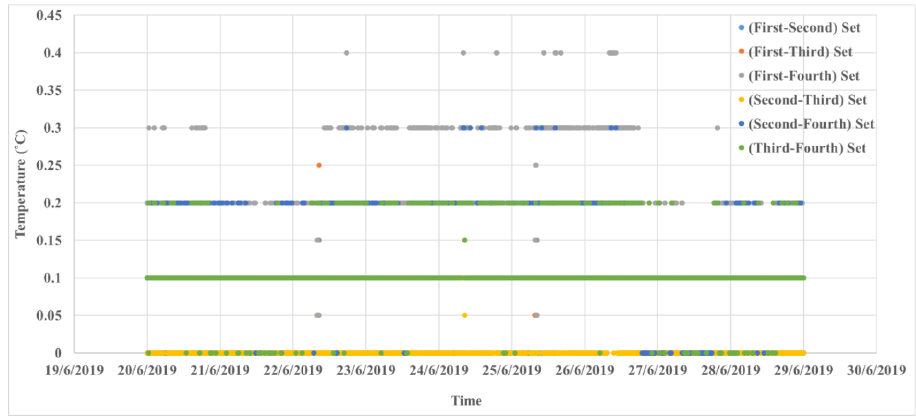
Figure 4. Temperature difference for the groups of sensors located at the same